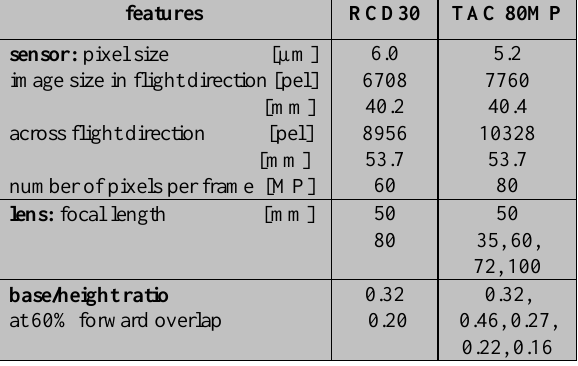
Table 1. Features of two new medium-format aerial cameras